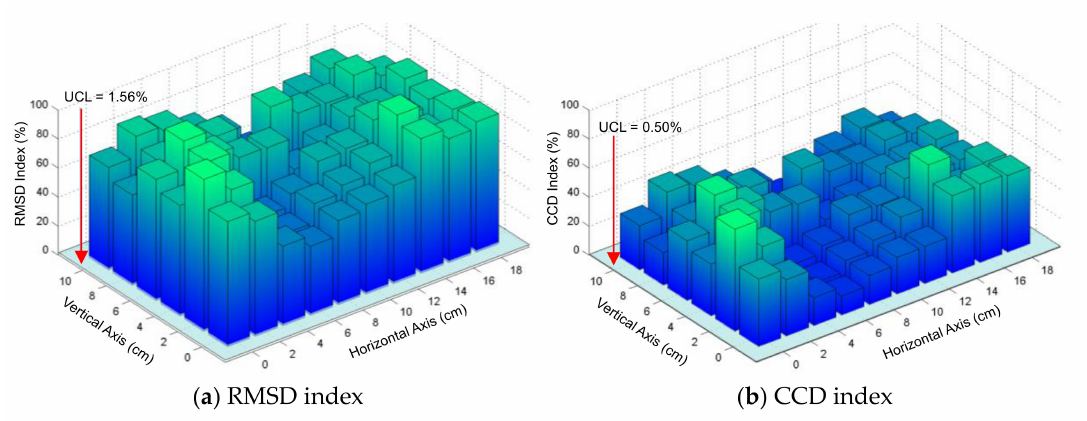
Figure 12. Damage detectability of PZT interface over a quarter of connection splice plate: 10–20